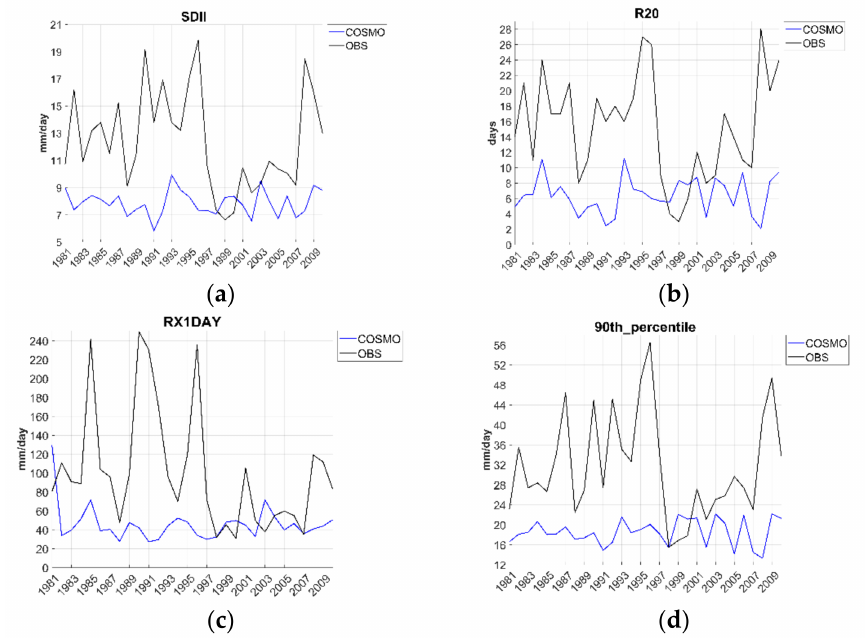
Figure 4. Time series of ( a ) SDII, ( b ) R20, ( c ) Rx1day, and ( d ) 90p-Prec for the model output of the simulation and observational data over the historical period